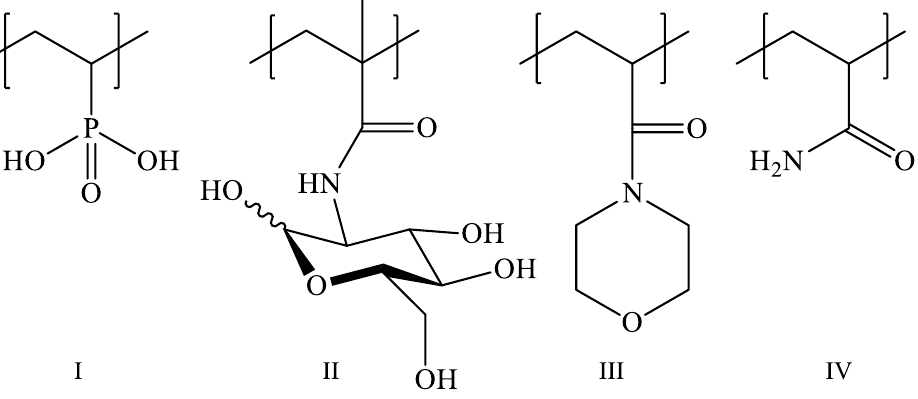
Figure 1. VPA ( I ), MAG ( II ), 4- АМ ( III ), АА ( IV )